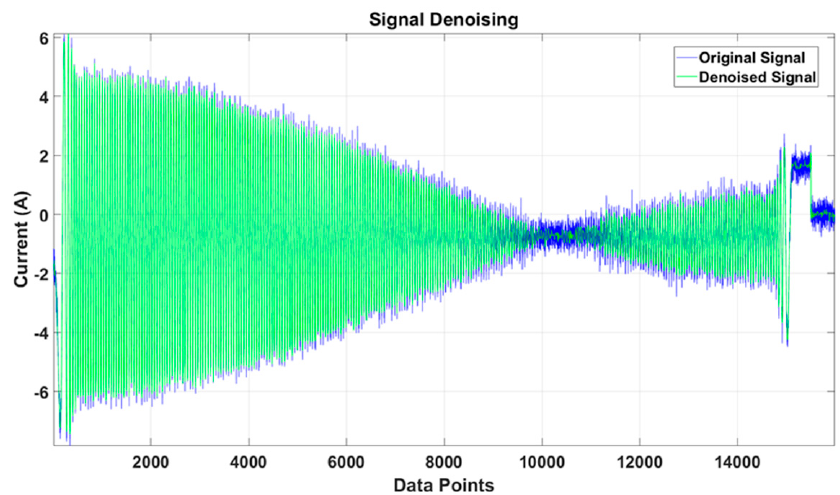
Figure 10. Flow of signal processing and data dimension conversion technique.